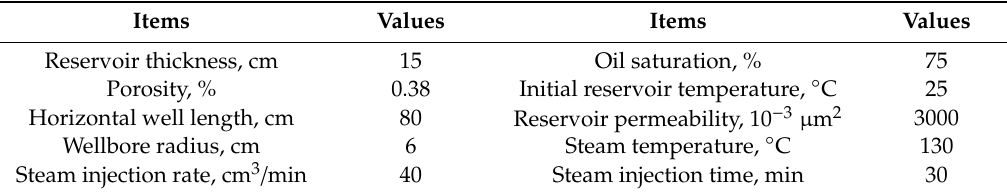
Table 1. Basic data used in the calculations.